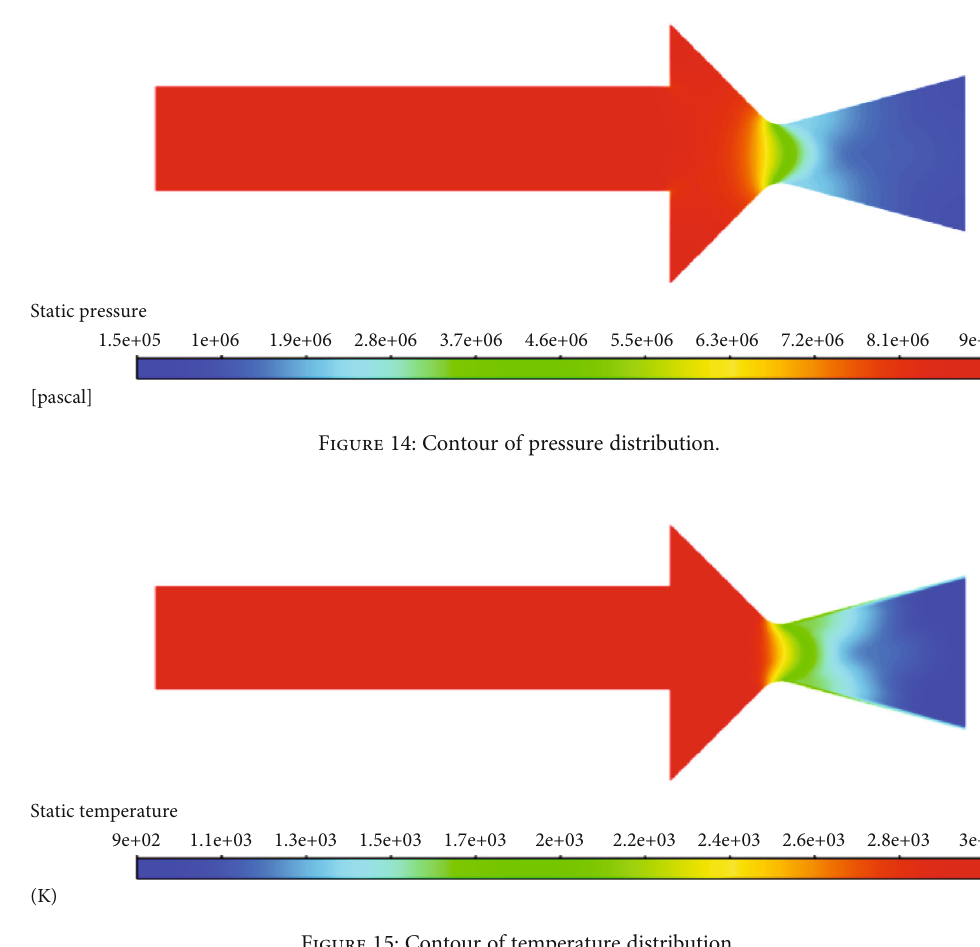
Figure 15: Contour of temperature